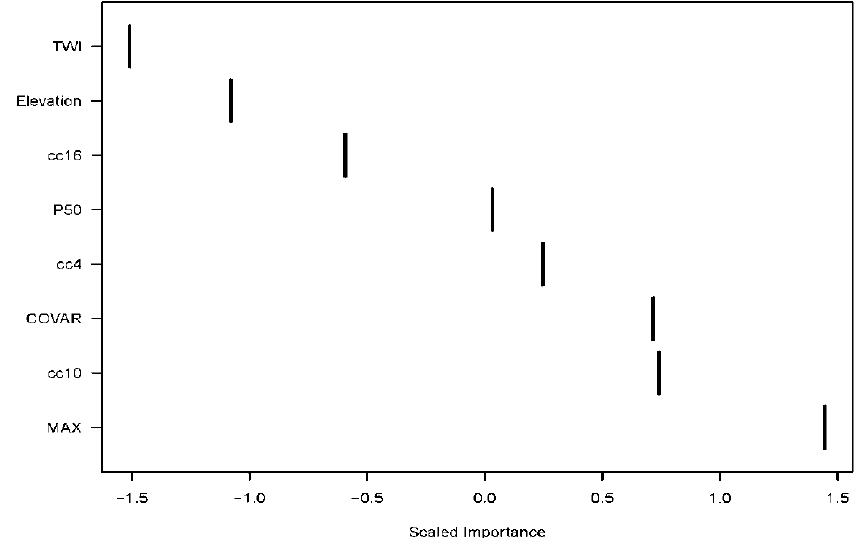
Figure 5. Scaled variable importance for rf-kNN age prediction model of 116 black spruce-dominated plots in the Hearst Forest of Northeastern Ontario.